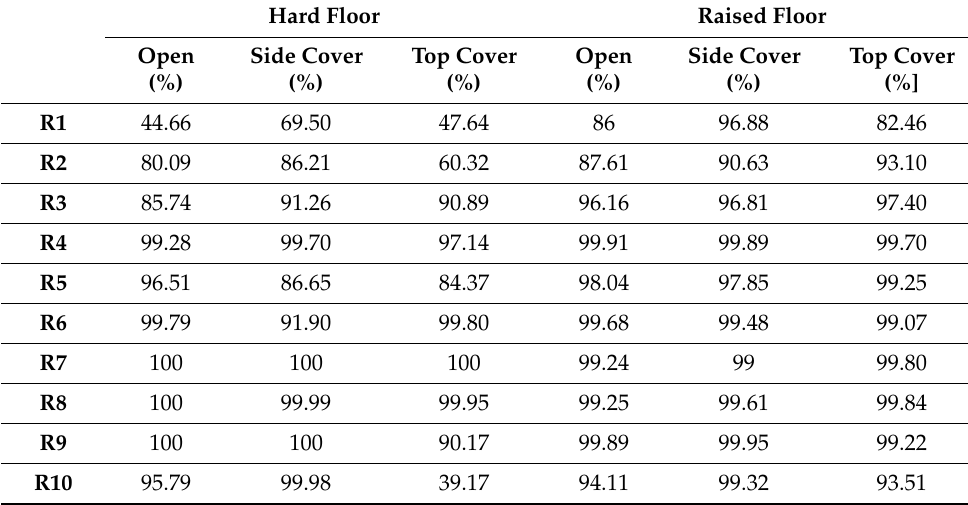
Table 6. CI for the server racks in all setups with 50% supply flow rate. Hard Floor Raised Floor